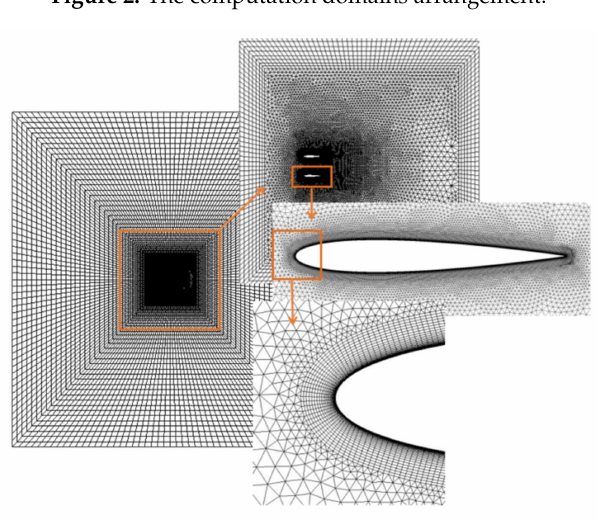
Figure 3. The mesh